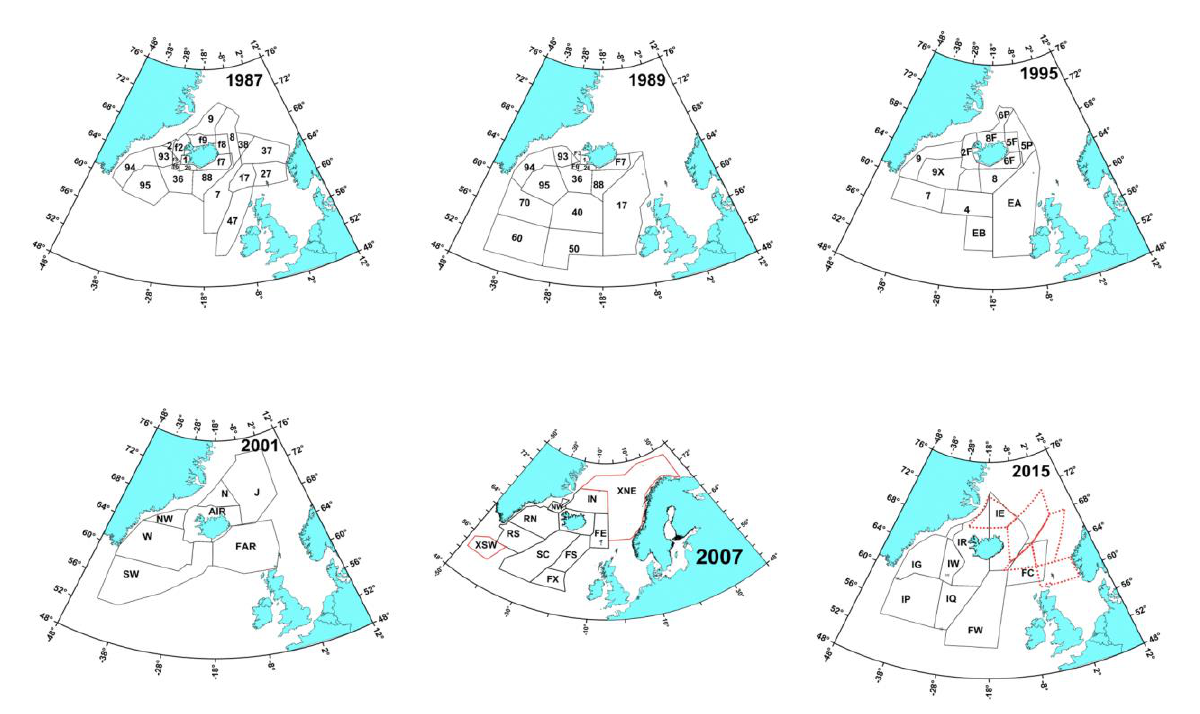
Figure 2. Stratification of NASS. Iceland is in the center of the maps. For 2007, extension strata are shown in red, and for 2015, overlapping strata from a concurrent Norwegian survey are shown in